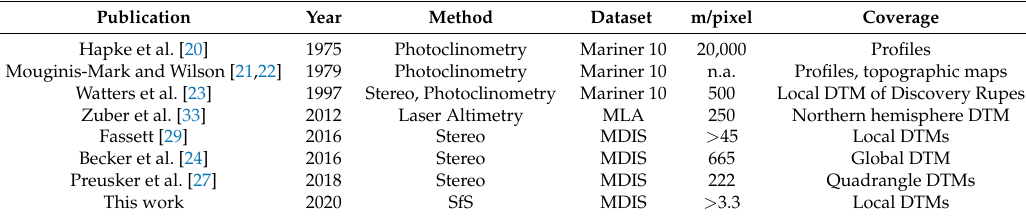
Table 1. Overview of surface reconstruction on